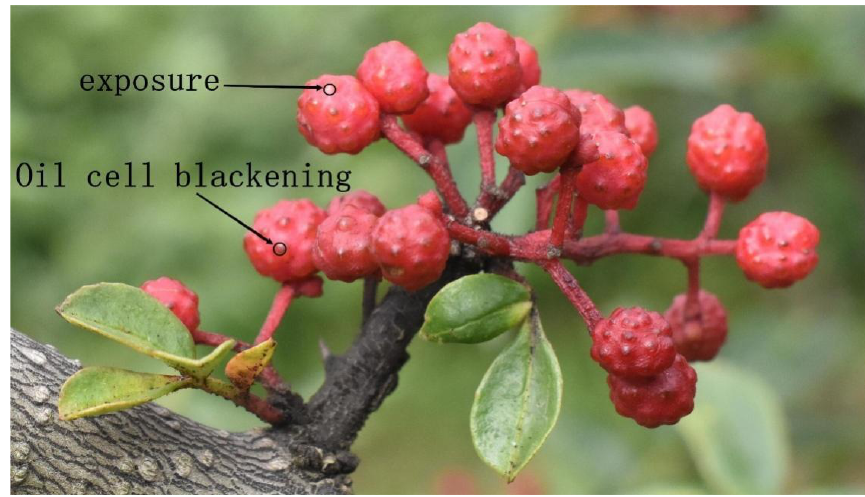
Figure 14. Picture of Sichuan pepper surface exposure, with oil cells turning black.